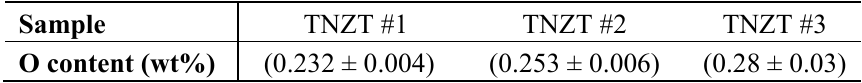
Table 2. Oxygen concentration in the TNZT samples.